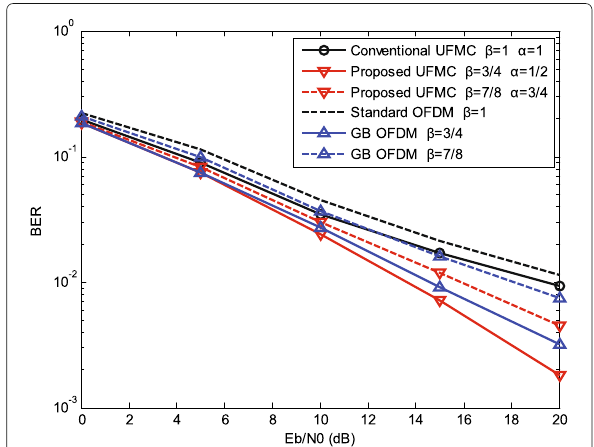
Fig. 5 BER performance comparison with different ratio factor α . This figure illustrates the BER performance of the proposed UFMC with different ratio factor and compared with the other systems